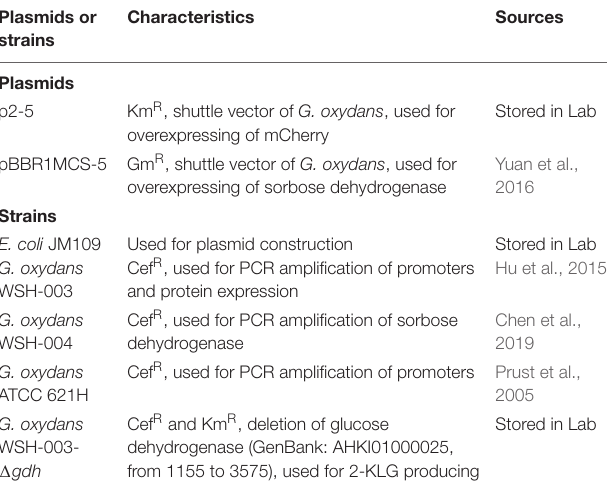
Table 1 . The nucleotide sequences of p2-5 and pBBR1MCS-5 were listed in Supplementary Table 5 . TABLE 1 | Plasmids and strains used in this